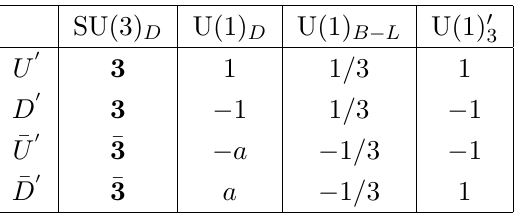
Table 2 . The charge assignment of the chiral composite ADM model. We take 0 < a < 1 , and hence, the U(1) gauge symmetry is not vector-like. The U(1) 0 symmetry is the third component D 3 of the dark isospin symmetry, SU(2) 0 V